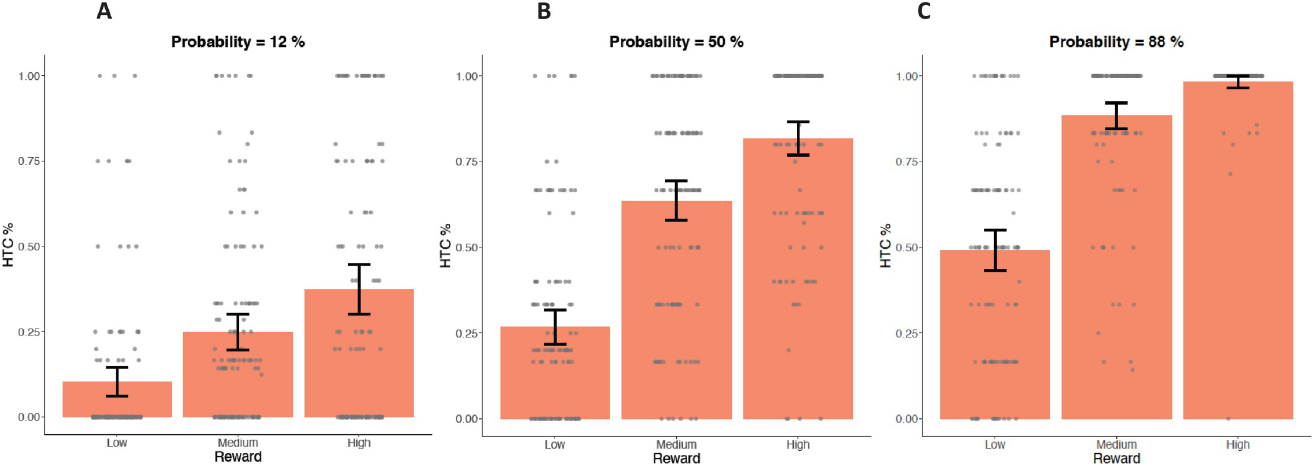
Fig 3. Percentage of hard-task-choices (HTC) within the original EEfRT in Study 1. Comparison of trials with low probability of reward attainment (left; A), medium probability of reward attainment (middle; B) and high probability of reward attainment (right, C) within the original EEfRT. For each probability category all three categories of reward magnitude (low / medium / high) are displayed. Data points are added as dots for individual scores. Error bars depict a 95% confidence interval (CI) of the mean.